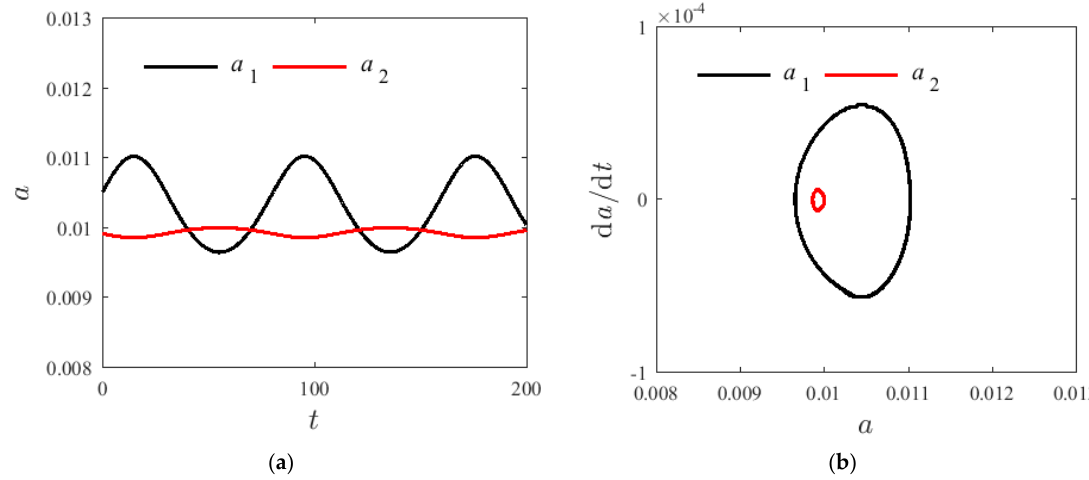
Figure 5. Internal resonances response curves v = 0; ( a ) time process diagram, ( b ) phase diagrams.